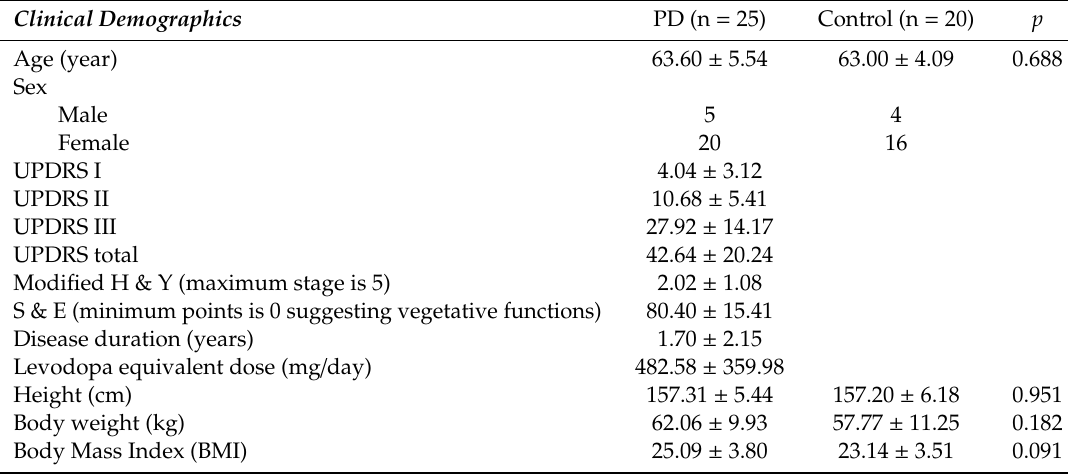
Table 1. Demographic data, disease severity, and assessments of frailty in patients with PD and control